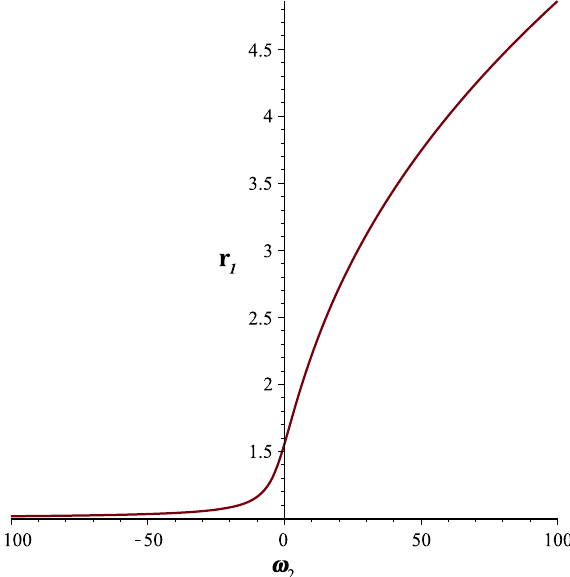
Fig. 12 The plot depicts the function r 1 (ω 2 ) as a function of ω 2 where ω = − so ρ + is not 2